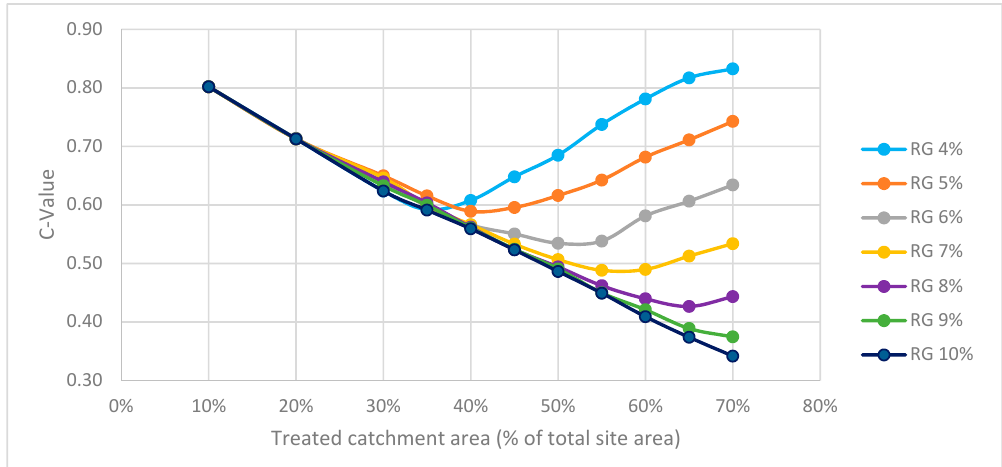
Figure 13. Residential precinct results of effective C-value versus treated catchment area for various rain garden sizes for the separate optimisation study.